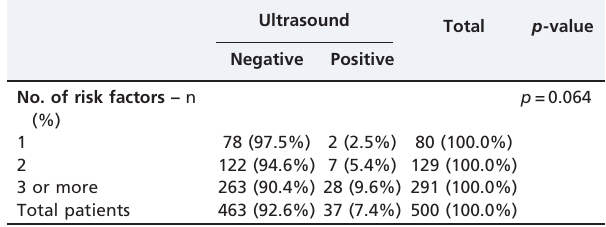
Table 4 - Association between the number of risk factors and the presence of carotid stenosis on